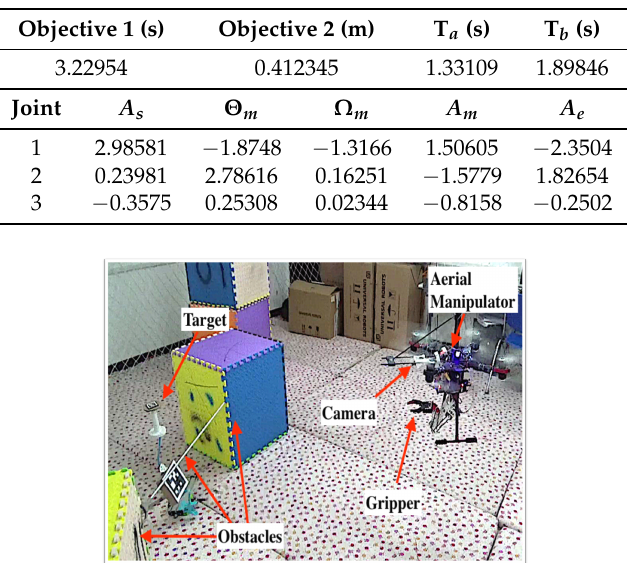
Table 2. Optimal trajectory planning result 2.